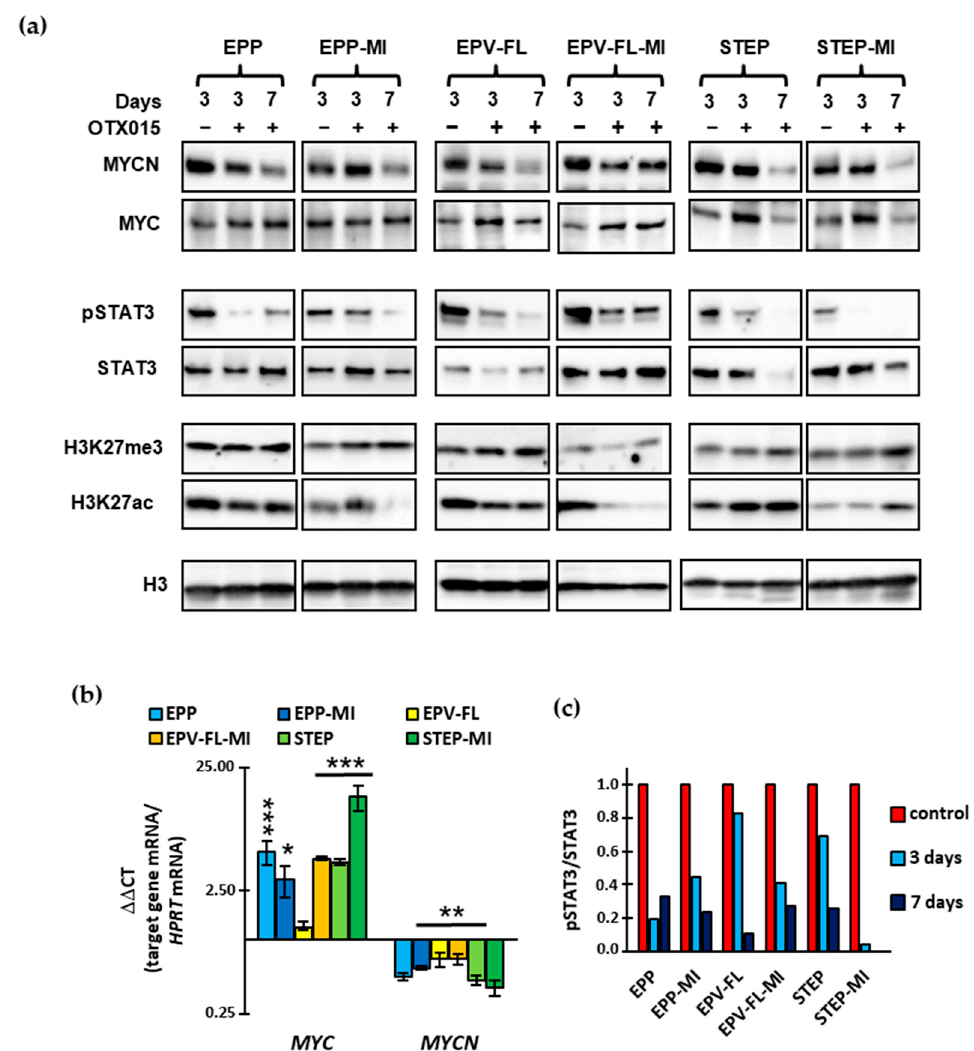
Figure 4. Effects of OTX015 on MYC and MYCN expression and the activation status of STAT3. ( a ) Western blot analysis of total lysates from EPN cells treated with a vehicle ( − ) or 500 nM OTX015 (+) for three and seven days. Blots were probed with the indicated antibodies. Histone 3 (H3) was used as a loading control. ( b ) qPCR analysis of expression of MYC and MYCN. Levels were normalized to the level of the reference gene hypoxanthine–guanine phosphoribosyltransferase (HPRT) in each sample. Means ± SD ( n = 3) relative to vehicle-treated controls, which were used as calibrators (1 = no change). Student’s t -test was used for statistical significance: * p < 0.05; ** p < 0.01; *** p < 0.001; significantly different from gene expression levels in the vehicle-treated controls. Not significant where no value is indicated. ( c ) Relative changes of phosphorylated STAT3 (pSTAT3) to the corresponding total protein shown in ( a ) were expressed as arbitrary units with respect of the control set to 1 and plotted as bar graphs. Cells treated with a vehicle only for three days were used as the control. OTX015 was used at 500 nM for three and seven days. Densitometry analysis of the bands was performed using the Image Lab software version 6.0.1 (Bio-Rad Laboratories, Inc., Hercules, CA,